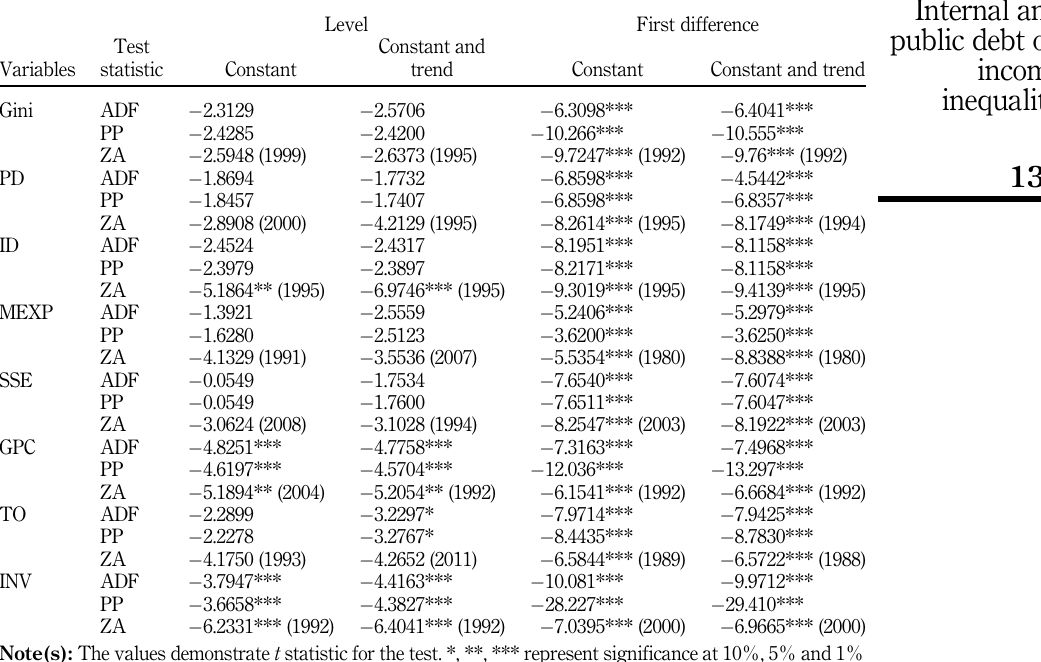
Table 3. Unit root tests